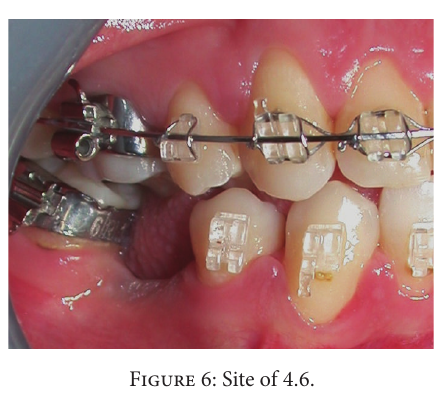
Figure 6: Site of 4.6.